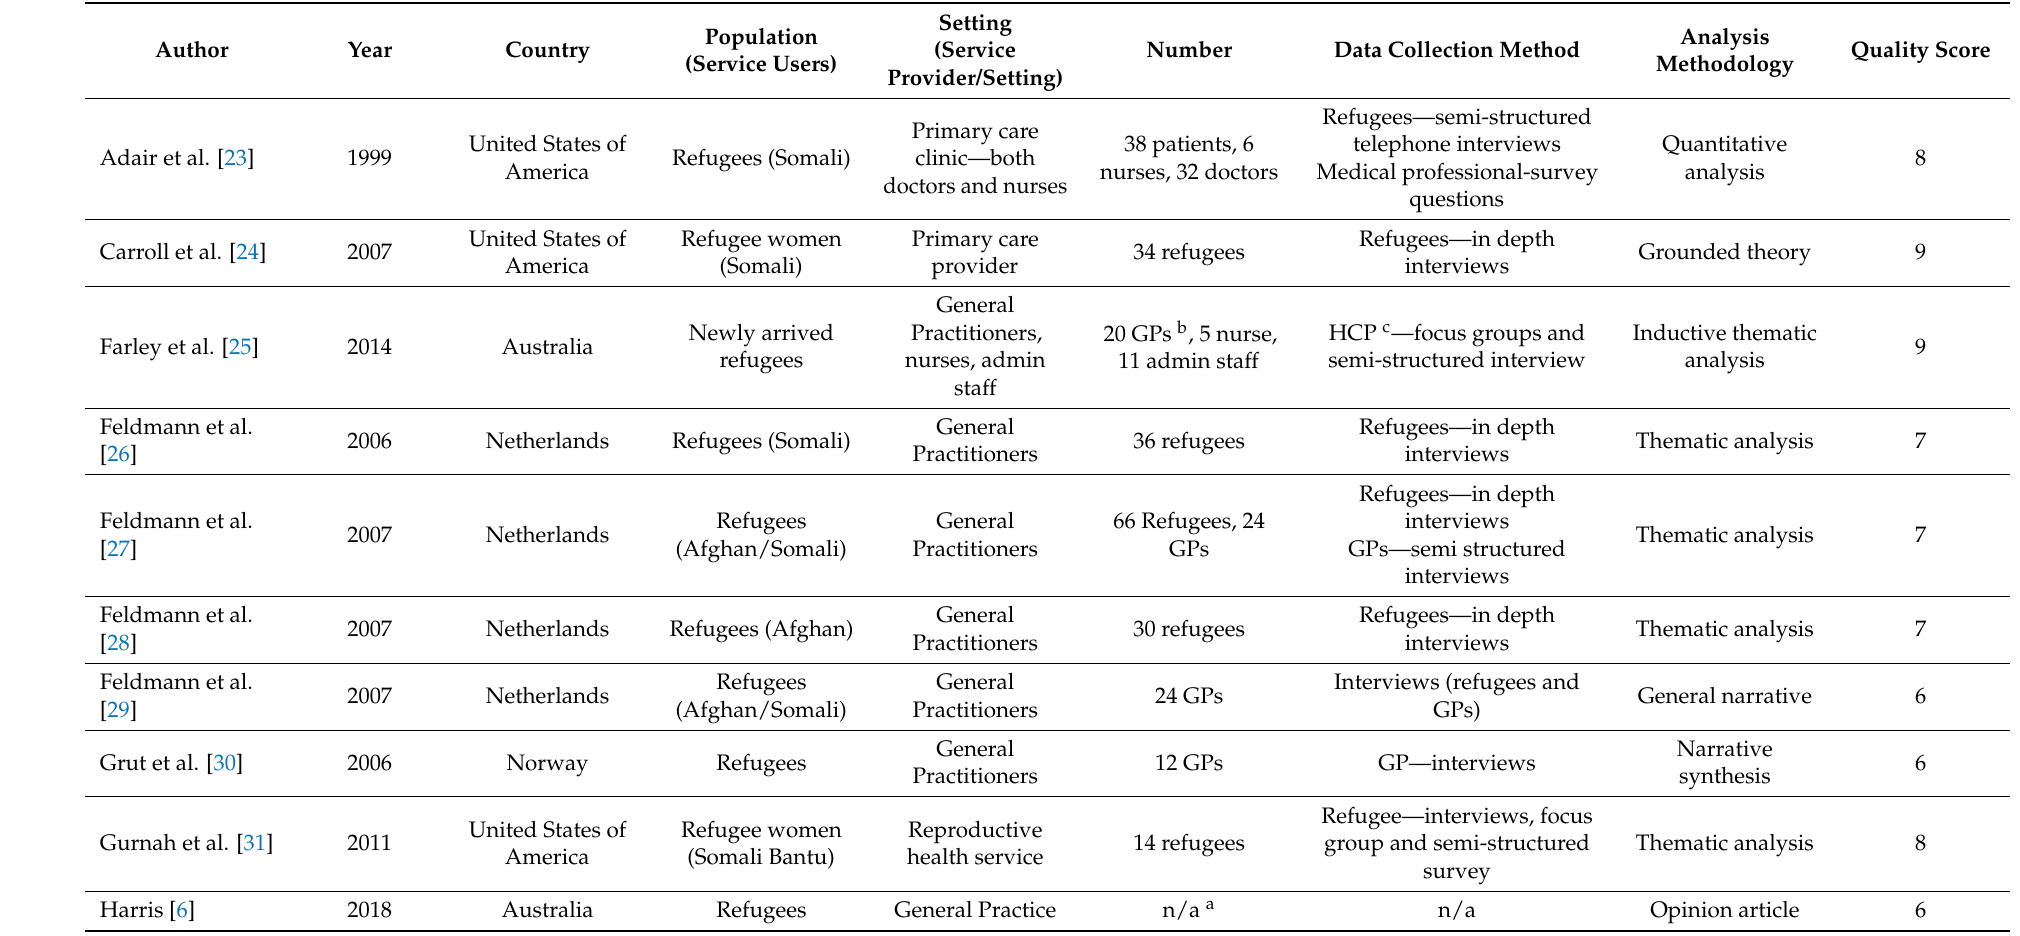
Table 1. Summary of participant and study characteristics of included